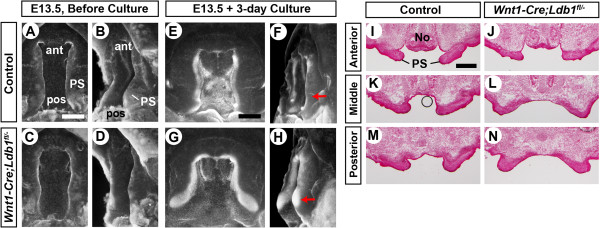
Removing the lower jaw does not restore the reorientation of the palatal shelves inWnt1-Cre;Ldb1fl/-mutants. The upper jaw region from E13.5 embryos, before culture (A-D) and after 3-day culture in the absence of the lower jaw and the tongue (E-N). A-H are fluorescent pictures of the heads processed by whole mount DAPI staining. (A,C,E,G) Intra-oral views directly into the palate. (B,D,F,H) Oblique views showing the profile of the palatal shelf. Red arrows in F and H point to the posterior palatae. (I-N) Coronal sections were stained with Nuclear Fast Red. Abbreviations: ant, anterior; pos, posterior; No, nose. Bar, 0.5 mm.